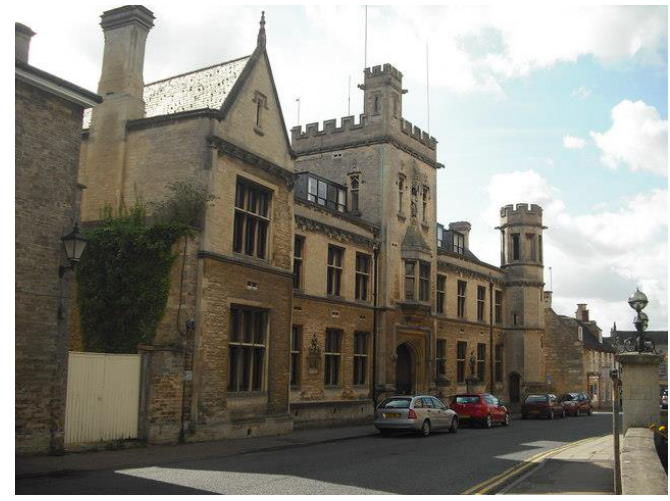
Figure 2. Oundle School.